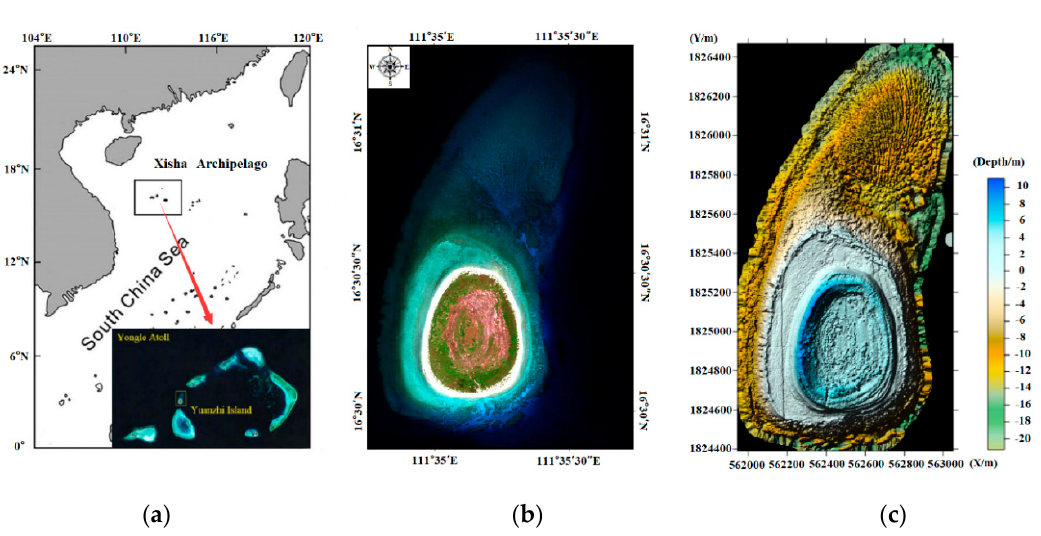
Figure 3. The survey area, Yuanzhi Island, is located in the Xisha Archipelago, South China Sea. ( a ) Location of the Xisha Archipelago; ( b ) overview map of the survey area; ( c ) 3D rendered water depth map of Yuanzhi Island.